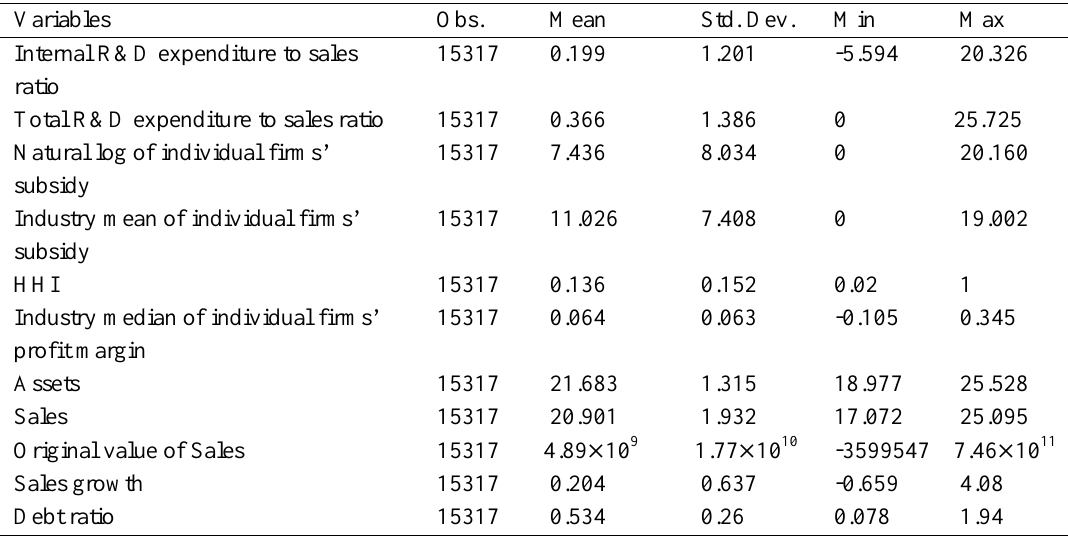
Table 1 : Summary